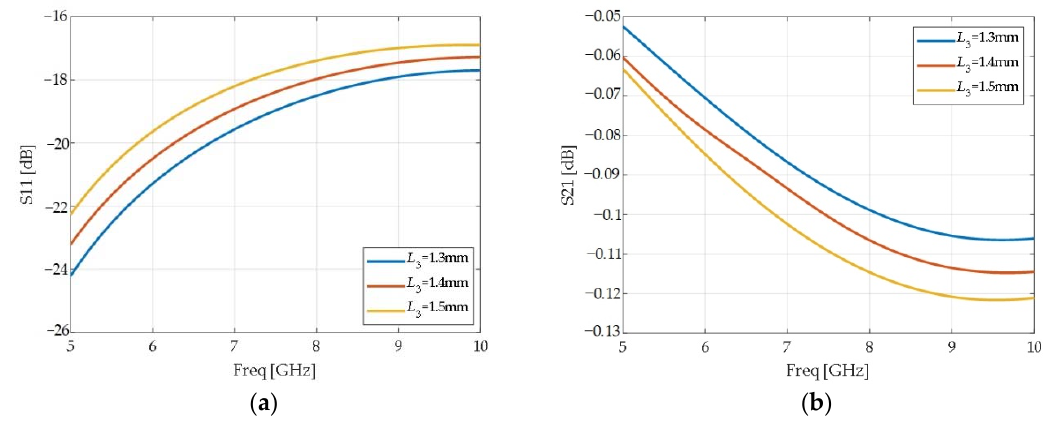
Figure 15. ( a ) S11 of lead wire interconnection with different lead wire lengths; ( b ) S21 of lead wire interconnection with different crack lead wire lengths.